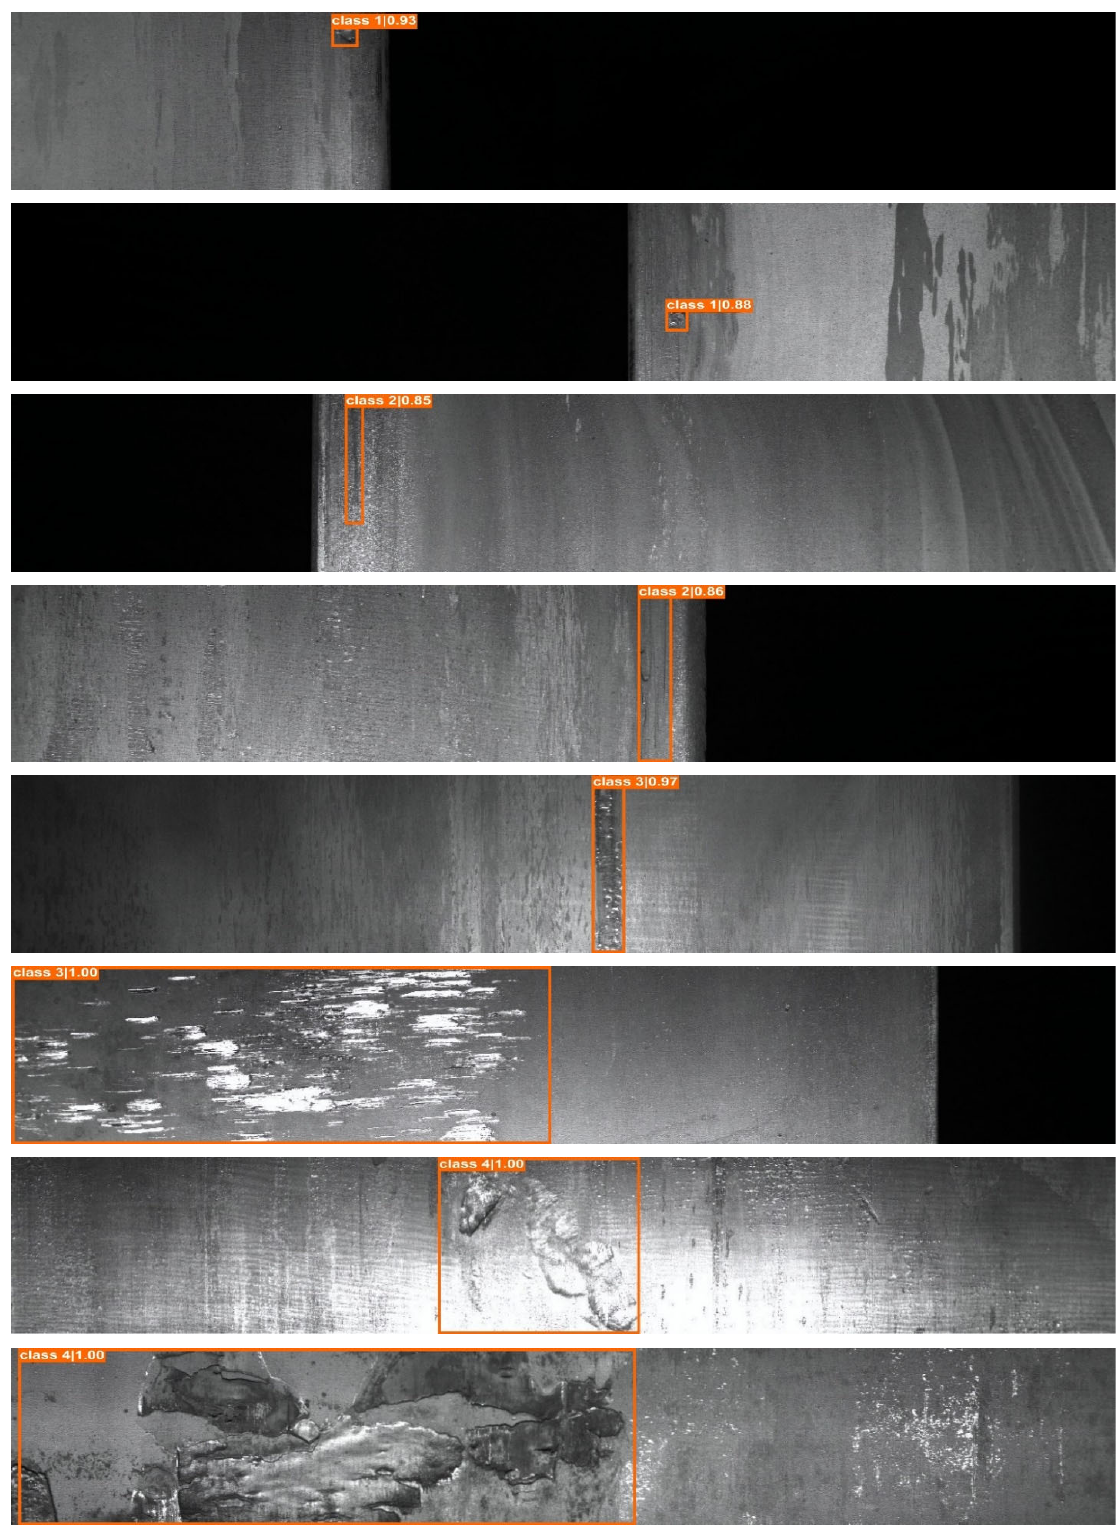
Figure 9. Sample of defect localization results for each class of the Severstal dataset.